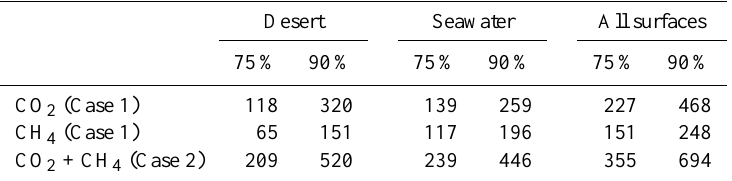
Table 3. Number of selected channels.